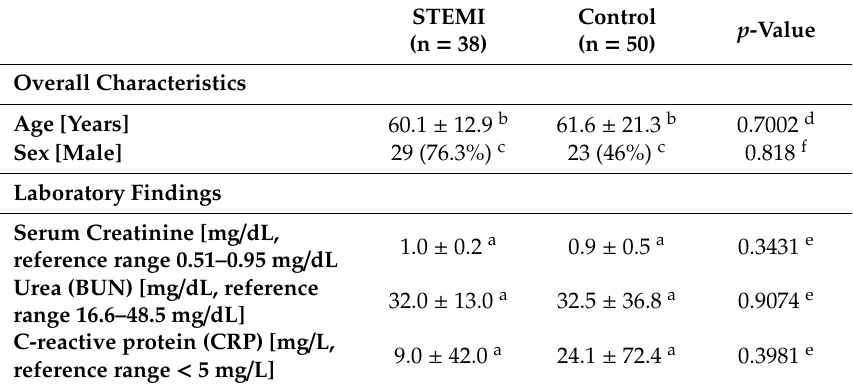
Table 1. Patient characteristics. a Presented as median ± interquartile range, b presented as mean ± standard deviation, c number of patients (with percentage based on the number of patients with a non-missing value for that characteristic), d based on Student’s t -test for variables following a Gaussian distribution, e based on Mann–Whitney U test for non-parametric variables, f based on chi-squared test / Fisher’s exact test as appropriate for categorical